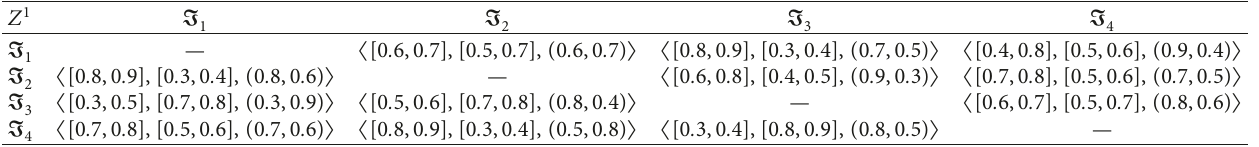
Table 1: CuPFPR with respect to the criteria “personal traits.”